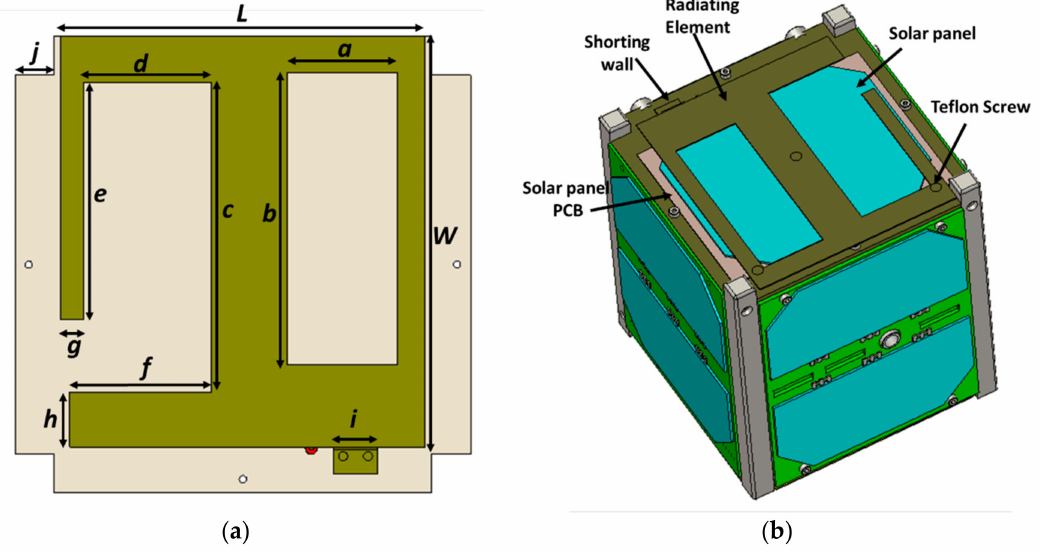
Figure 1. ( a ) Design layout of the proposed antenna; yellow radiating patch and gray ground plane, ( b ) antenna integrated with 1U nanosatellite structure, solar panel placed in between the radiating patch and the ground plane.